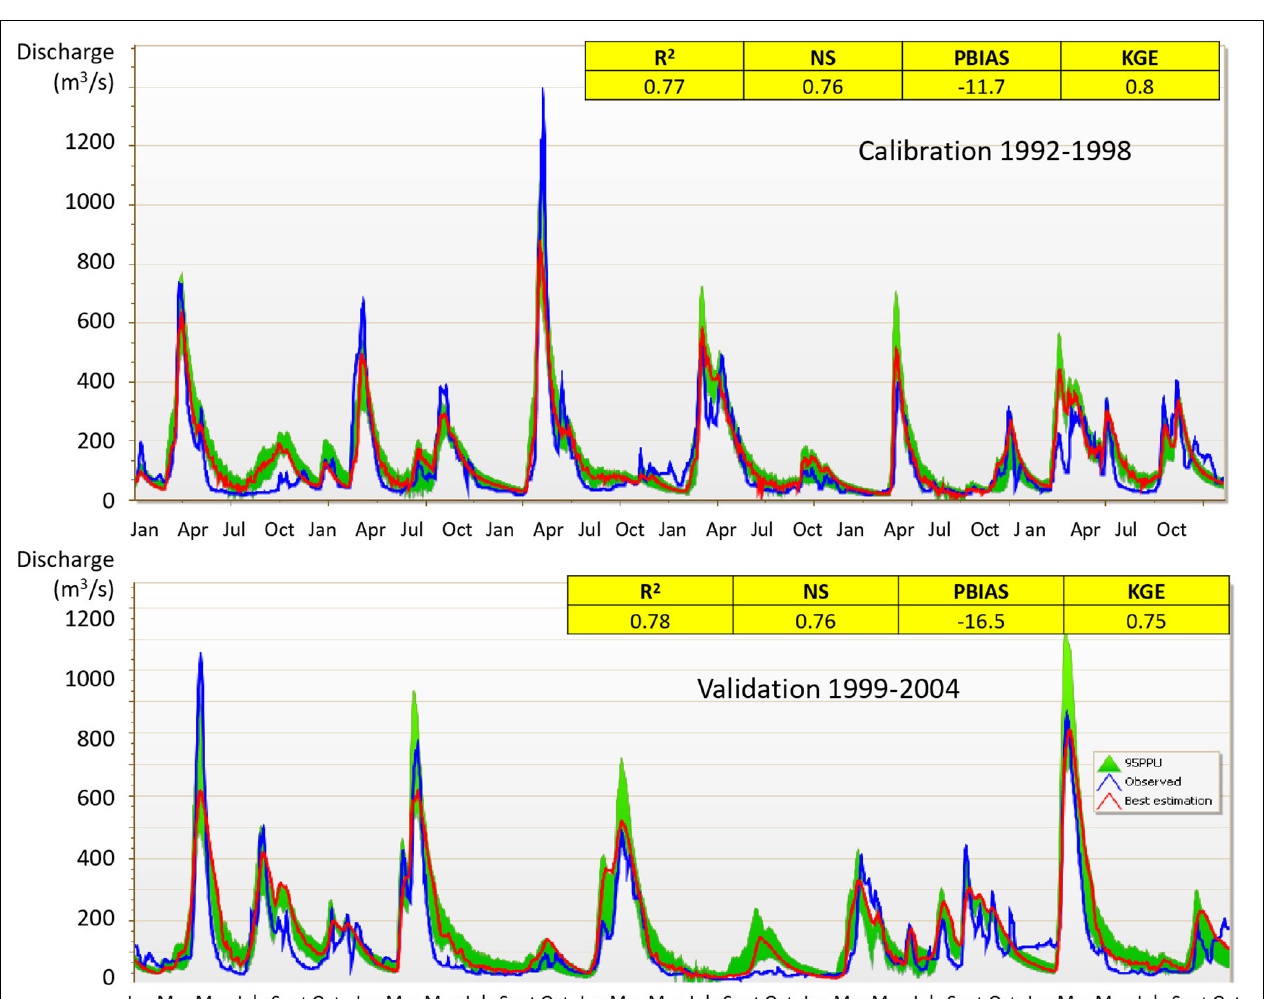
FIGURE 6 | Model calibration and validation. Western Dvina river at Velizh town, blue line represents measured runoff, red line – simulated runoff in cubic meters per second (Q, m 3 /s), green area – 95 percent prediction uncertainty range (95